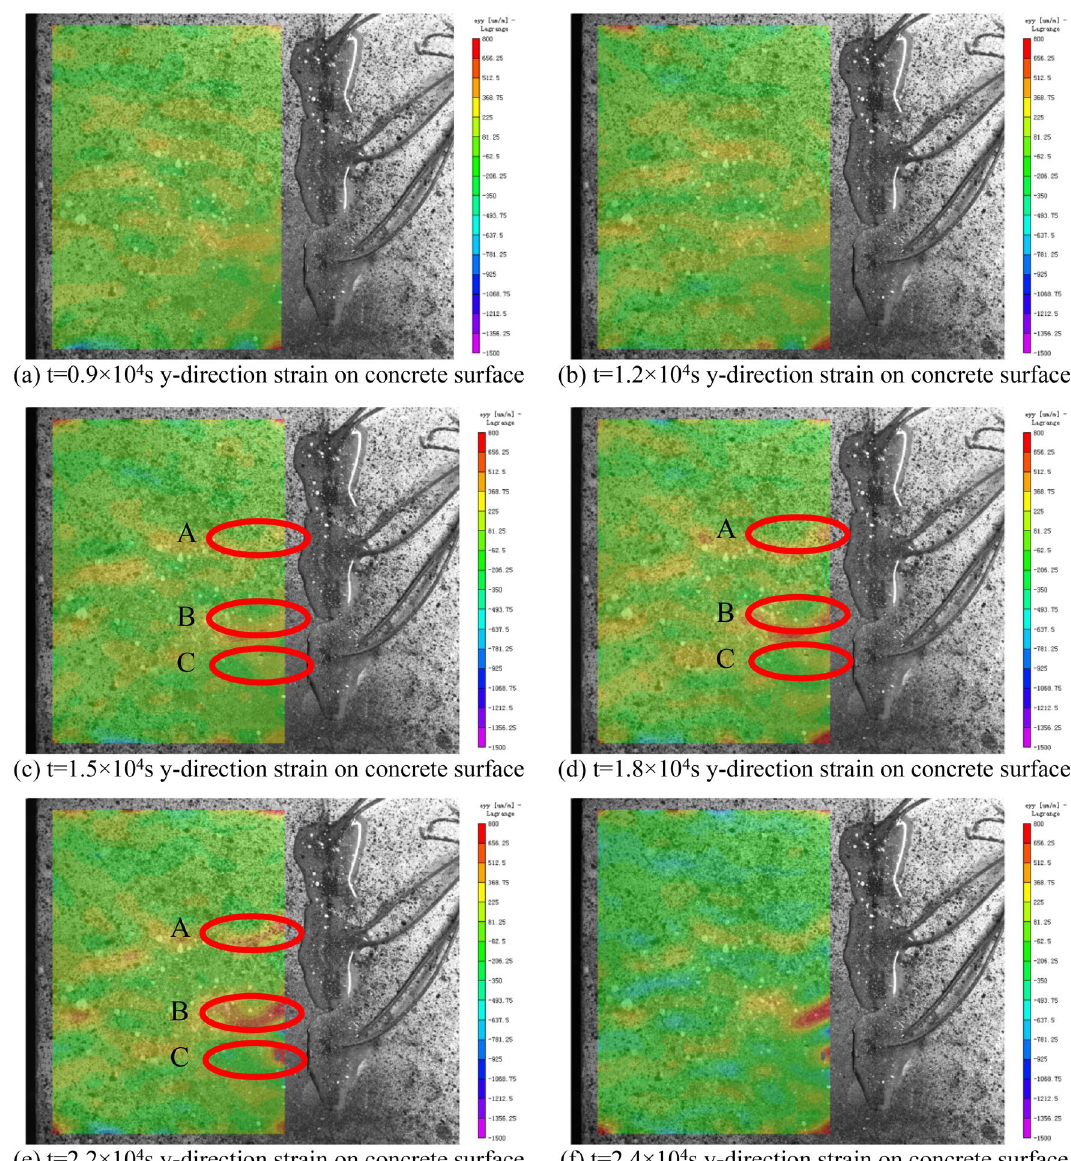
Figure 10. The y-direction strain on concrete